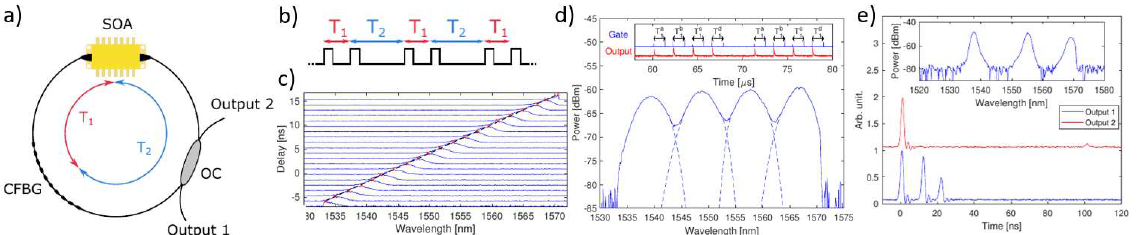
Fig. 1 A schematic depiction of the C-cavity layout is given in a) and the gating sequence shown in b). The achieved tuning characteristics are shown in c). Time-multiplexed four wavelength operation is demonstrated in d) and e) shows the output pulse sequences from the two outputs when using a common gate in one